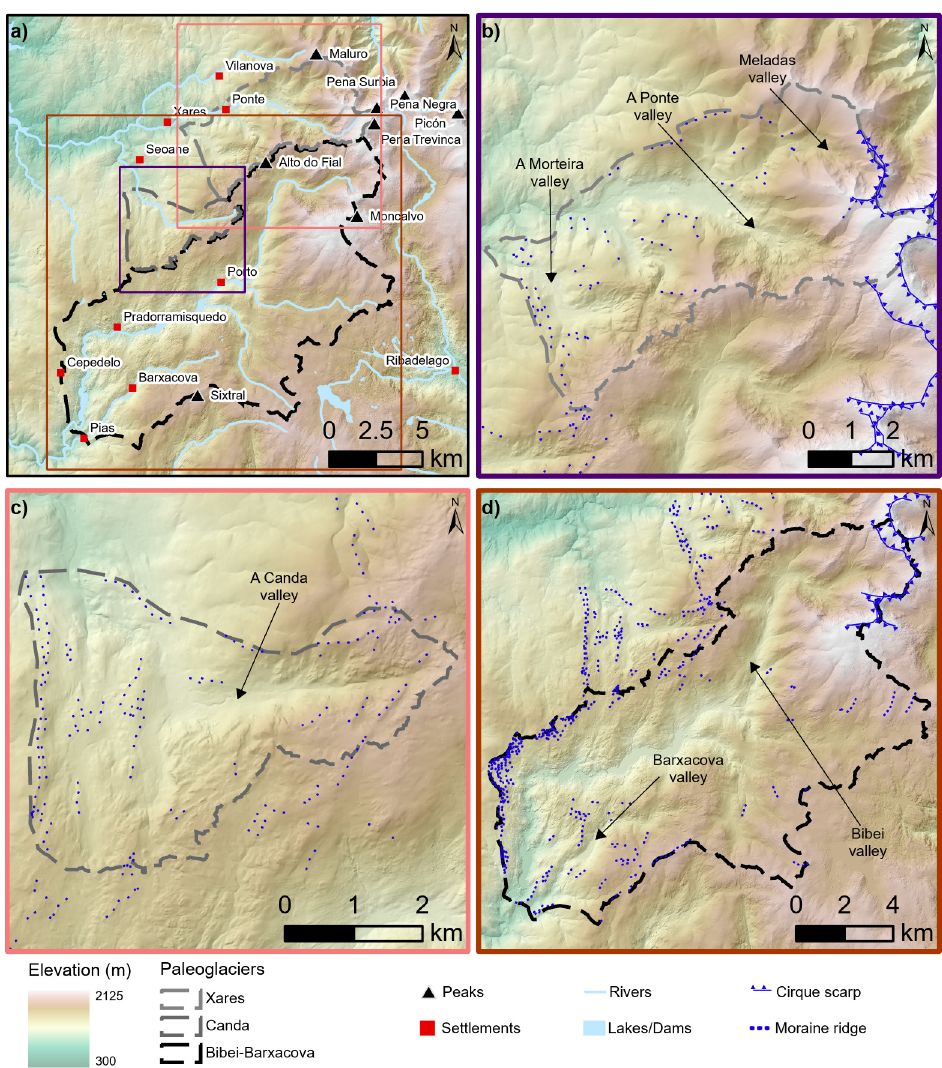
Figure 8. Paleoglacial basins on occidental Trevinca Massif. ( a ) General map with the paleobasins of ( b – d ). ( b ) Xares paleobasin; ( c ) Canda paleobasin; and ( d ) Bibei-Barxacova paleobasin. The contour colors of ( b – d ) represent the extension marked with the same colors in ( a ).